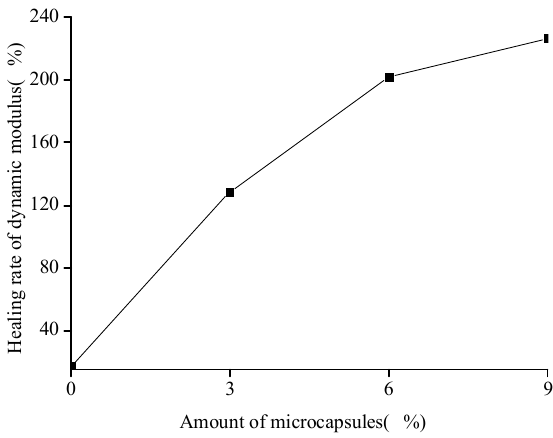
Figure 8. Healing rate (Equation (6)) of the dynamic modulus with the amount of microcapsules.